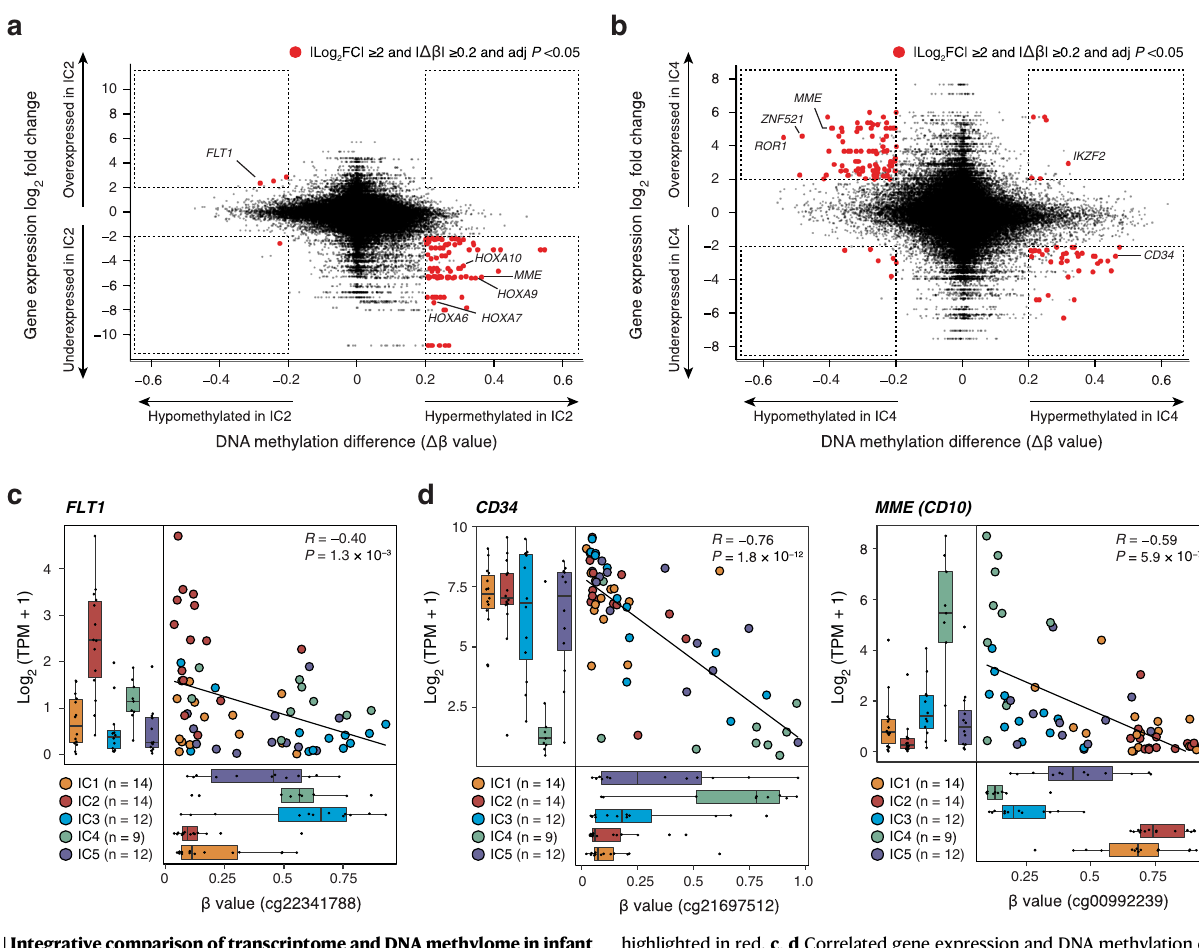
highlighted in red. c , d Correlated gene expression and DNA methylation of dual- omicsclustermarkers FLT1 ( c ), CD34 and MME ( d ).Pearsoncorrelationcoef fi cients ( R ) and raw Pearsoncorrelation P valuesare indicated. Boxplots show median and fi rst/third quartiles. The whisker extends from the smallest to the largest values within 1.5×IQR from the box